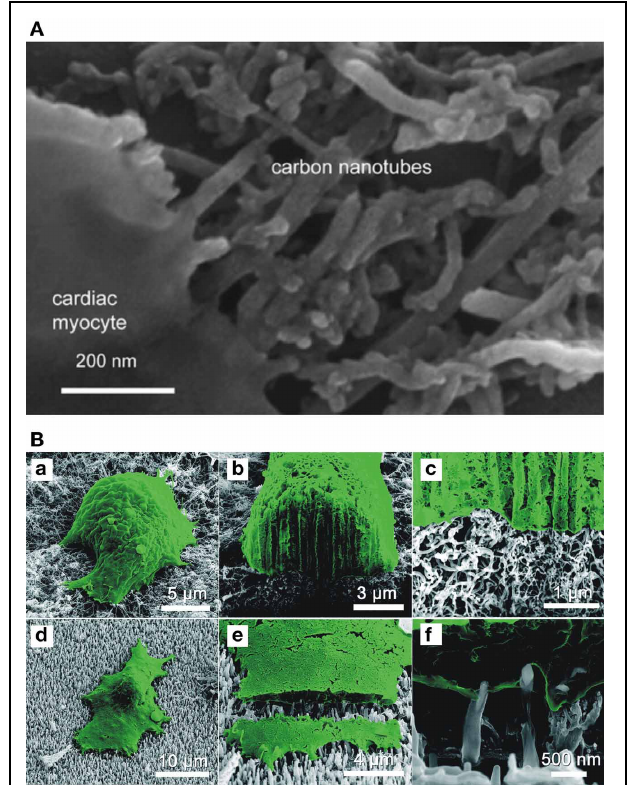
FIGURE 1 | Cardiomyocytes intimately hybridize with CNTs substrates. (A) Scanning electron micrograph showing the close interactions between the membrane of a cultured cardiomyocyte and the CNTs growth substrate. Reprinted with permission from Martinelli et al. (2013). (B) Scanning electron micrographs of myocytes (in false color) cultured on randomly-oriented CNTs (a–c) or on vertically-aligned CNTs (d–f). On the vertically aligned substrate, single CNTs cross the membrane and penetrate into the intracellular space. Reprinted with permission from Fung et al.